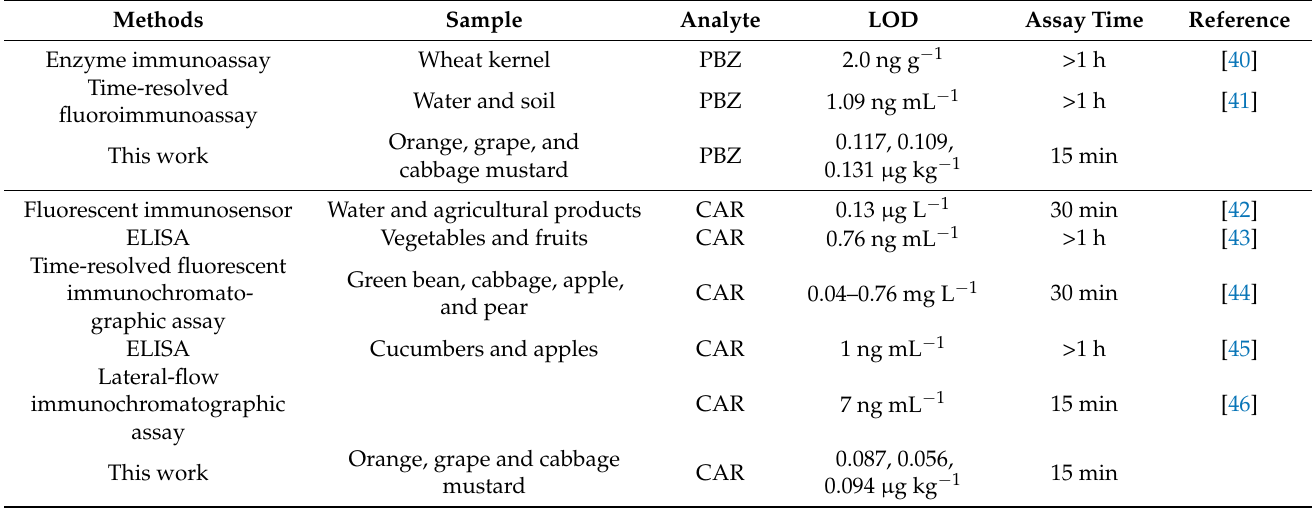
Table 1. Advances in the detection of immunological methods for PBZ and CAR.